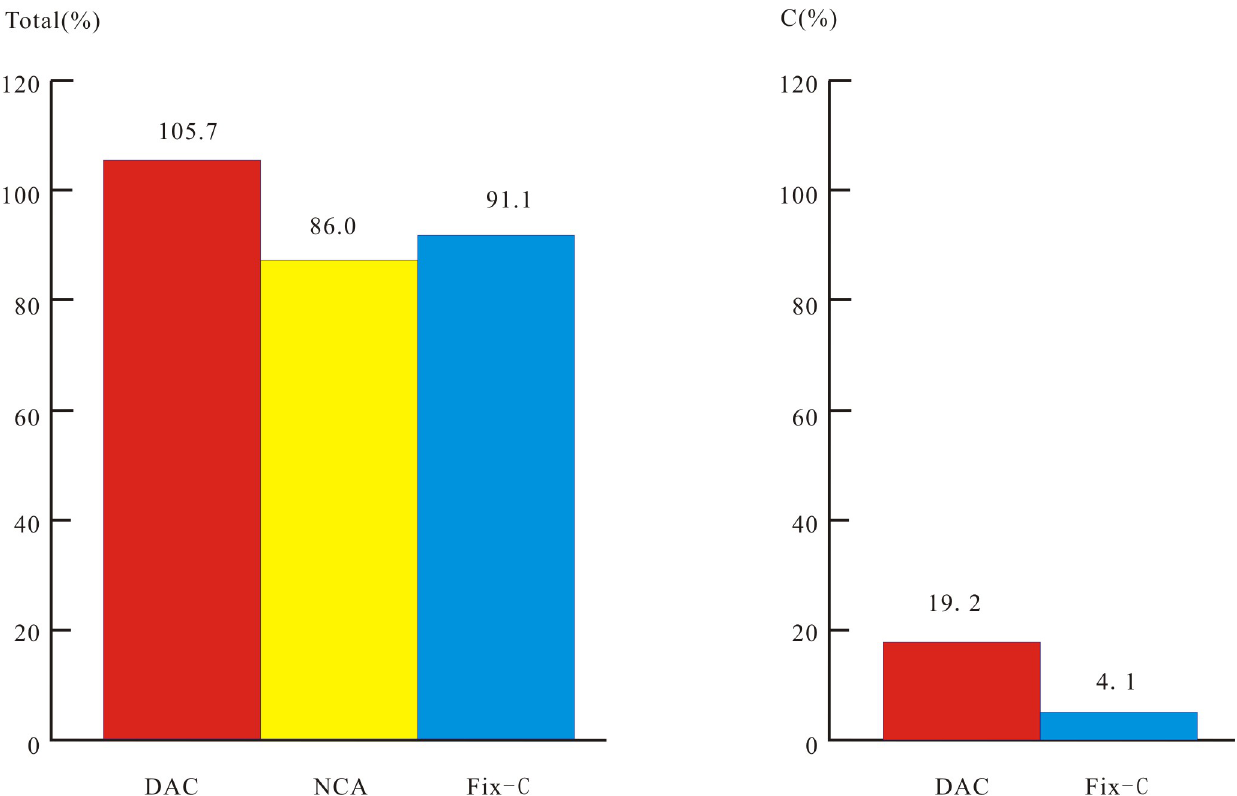
Fig 4. The difference between the average total values of phytolith EPMA by using three model. Note: Phytoliths were extracted from D . ronganensis leaves. The total number of phytolith particles used for EPMA were 24. Fix-C carbon value was equivalent to the PhytOC value.